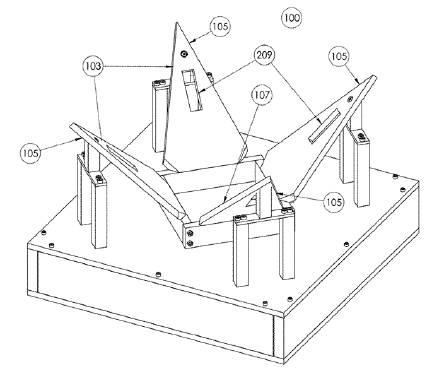
Figure 38. Aircraft docking station with a closed contour for positioning [93] by American Robotics Inc. 100, docking station; 103, centering system; 105,